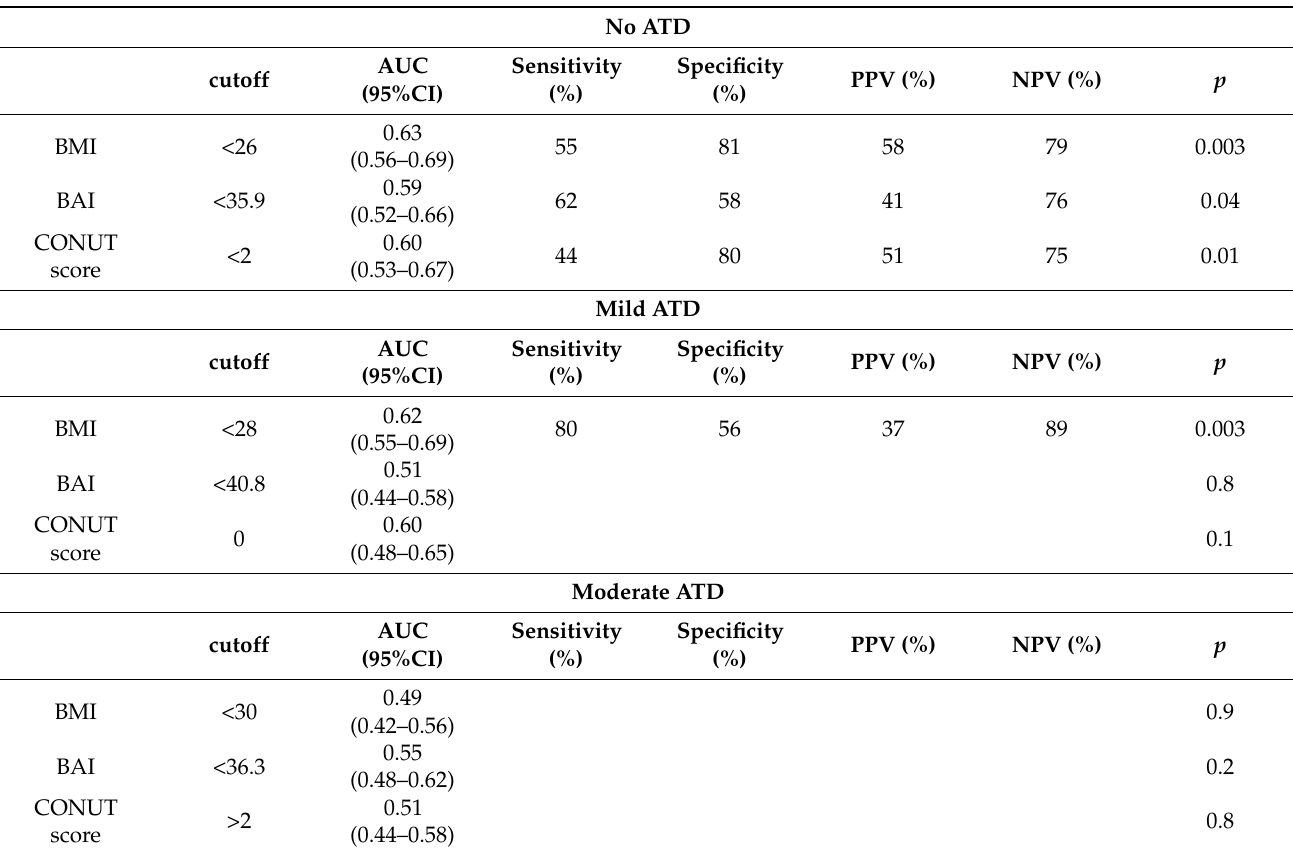
Figure 5. The distribution of VAI-defined adipose tissue dysfunction (ATD) types in respective CONUT score-defined nutritional status ( A ) and the distribution of nutritional status in respective VAI-defined types of adipose tissue dysfunction (ATD) ( B ). Table 5. Receiver-operating characteristics (ROC) curves identifying discrimination thresholds of BAI and BMI for VAI- defined adipose tissue dysfunction